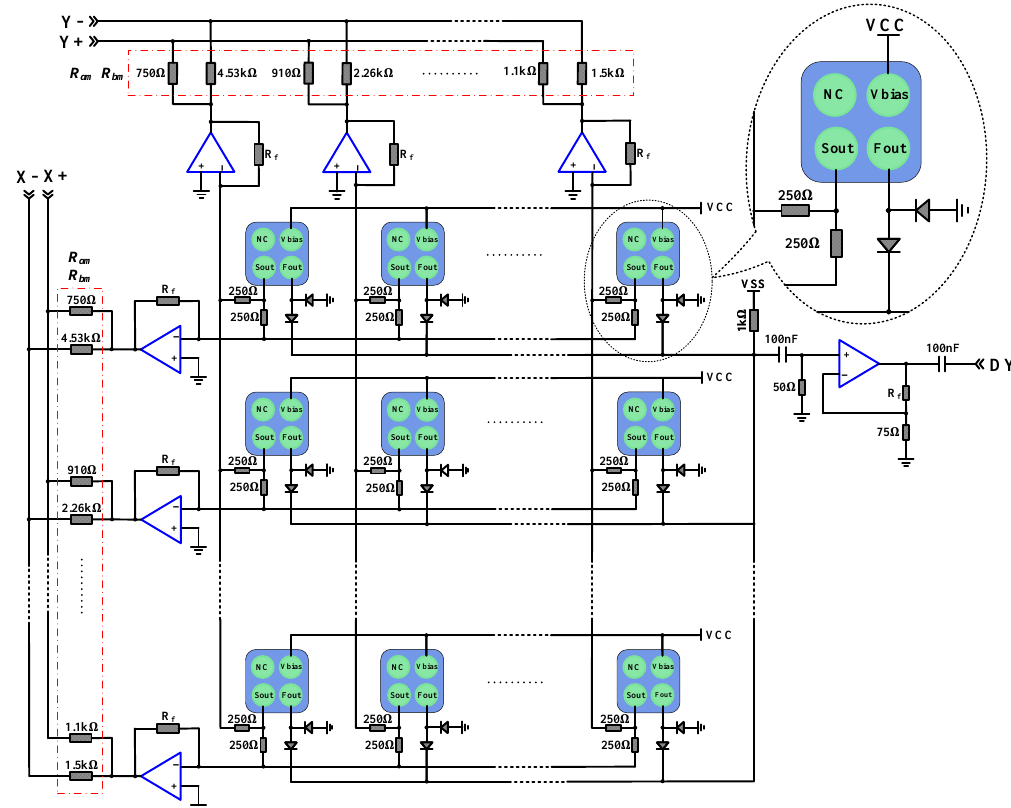
Figure 5. Schematic of the multiplex circuit for SiPM array F out signals and S out